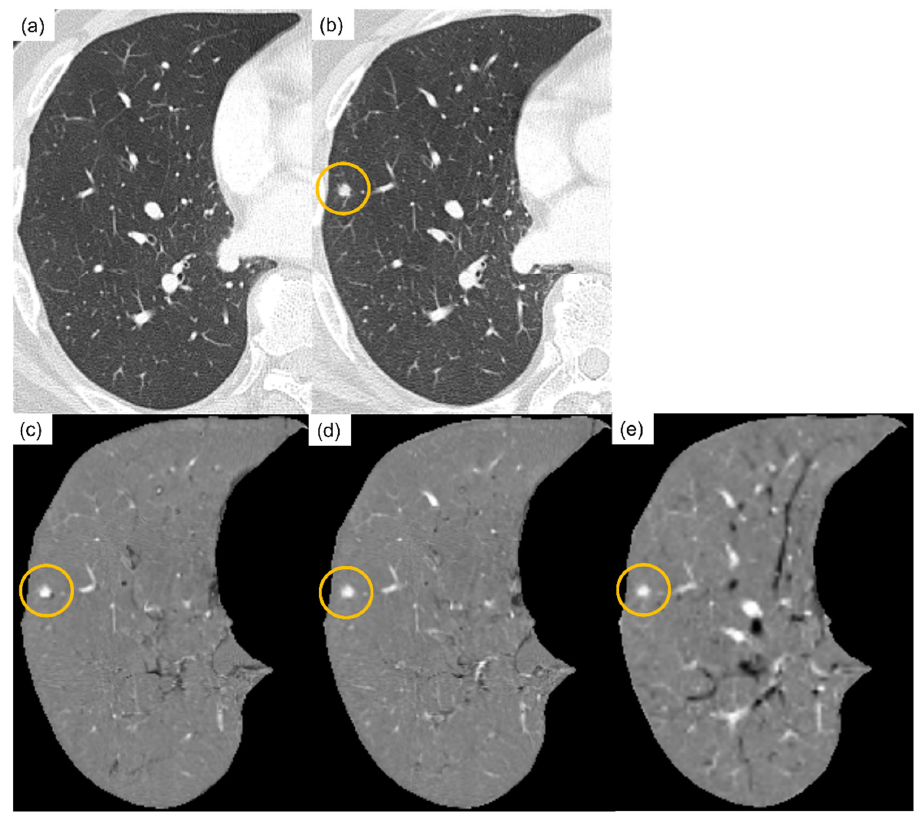
Figure 7. Comparison of the results of applying ResidualVoxelMorph with the proposal method, VoxelMorph with the proposal method, and conventional VoxelMorph to the previous and current CT image pair. ( a ) Shows a previous CT image, ( b ) a current CT image, ( c ) a temporal subtraction image from ResidualVoxelMorph with the proposal method, ( d ) a temporal subtraction image from VoxelMorph with the proposal method, and ( e ) a temporal subtraction image from conventional VoxelMorph. Lesions are circled.